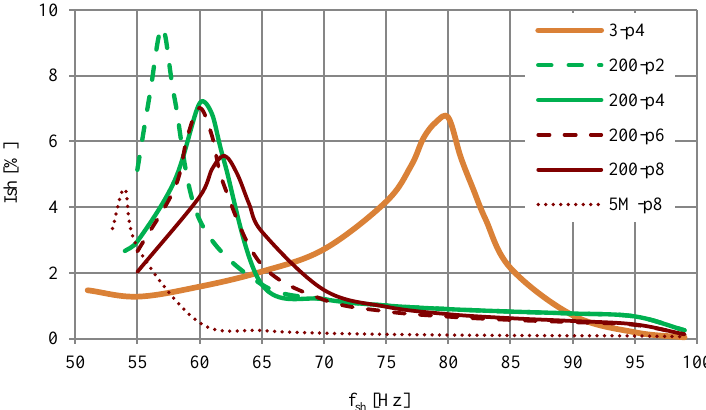
Figure 8. Computed current subharmonics vs. the frequency of voltage interharmonics for the various motors and the case of NMI.